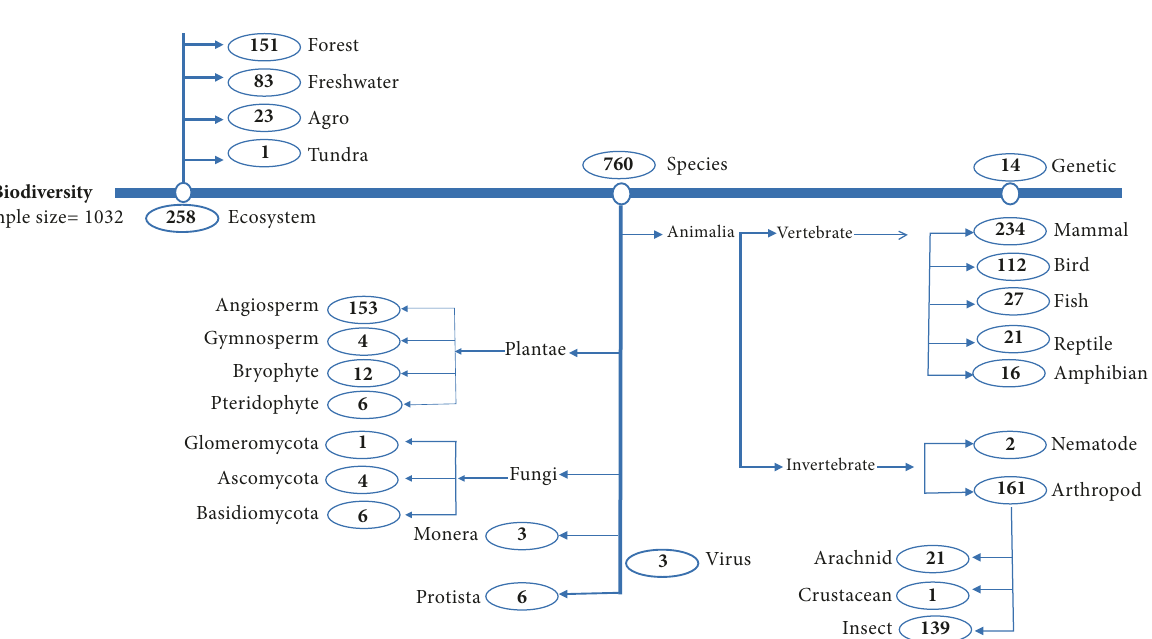
Figure 4: Total number of publications for different biodiversity levels in the Far-Eastern Himalayan